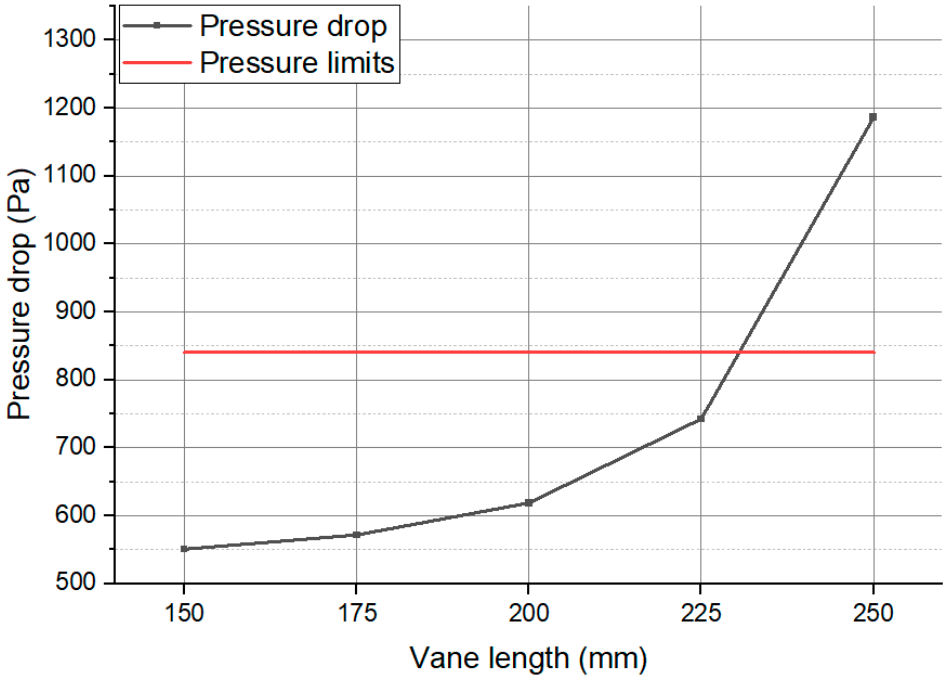
Figure 19. Pressure drop according to the vane length in the outer vane type.